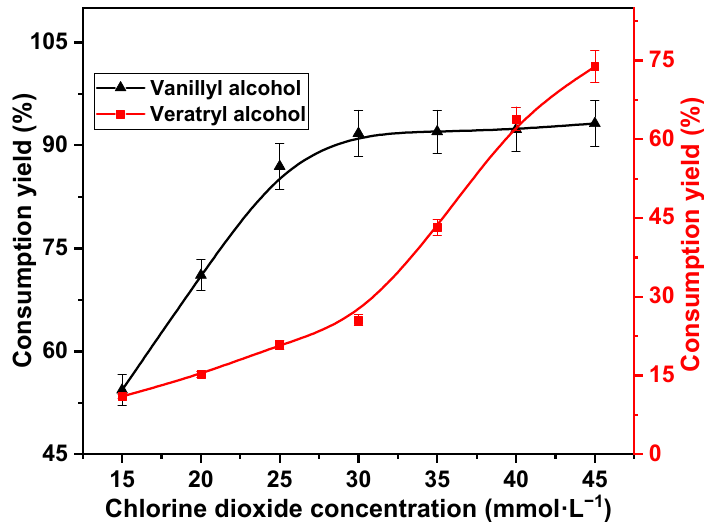
Figure 1. Effect of chlorine dioxide concentration on vanillyl alcohol and veratryl alcohol consumption. The consumption of vanillyl alcohol increased rapidly with increasing chlorine dioxide concentration up to 30 mmol · L − 1 . The consumption yield increased significantly from 54.4% to 91.8%. This was attributed to the higher oxidative activity of the phenolic lignin than the non-phenolic lignin [31]. The reactivity of vanillyl alcohol with chlorine dioxide remained stable at chlorine dioxide concentrations higher than 30 mmol · L − 1 .